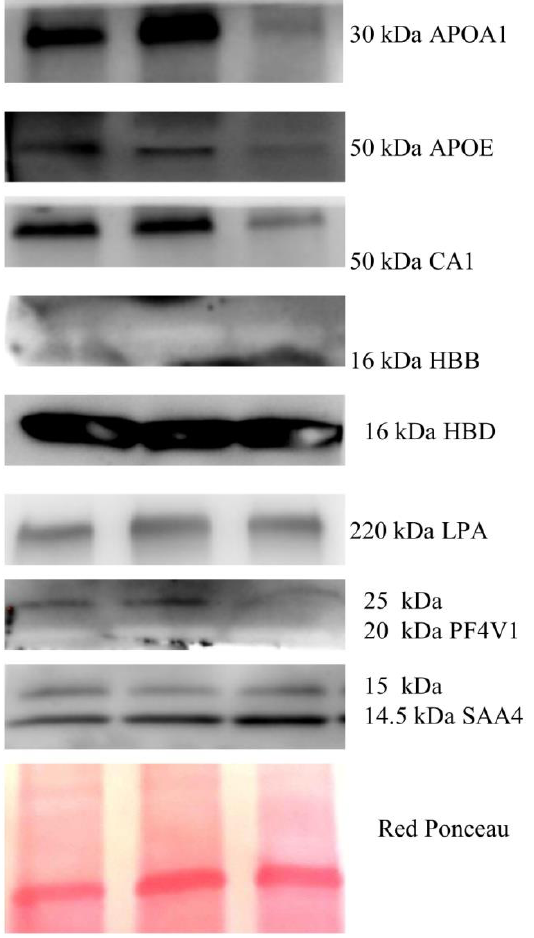
Figure 3. Western blotting of proteins APOA1, APOE, CA1, HBB, HBD, LPA, PF4V1, and SAA4 present in EC.